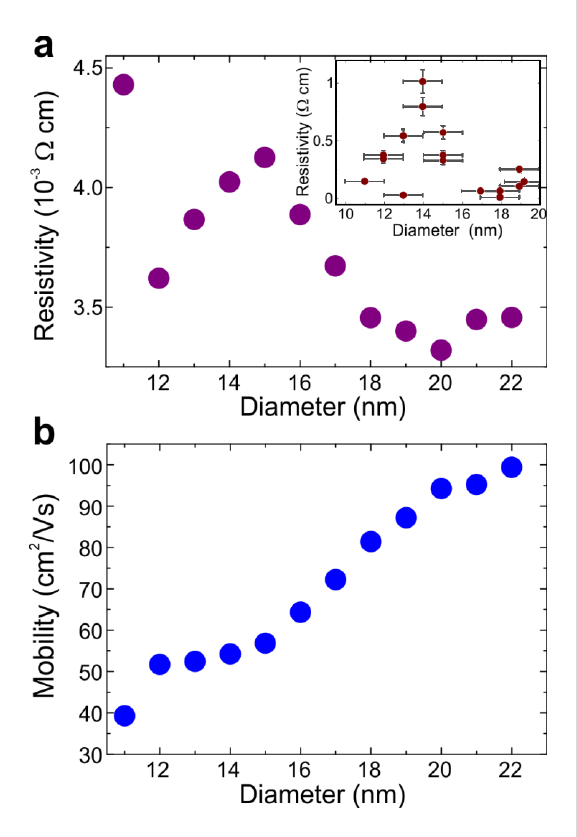
Figure 3: (a) Calculated nanowire resistivity from 22 to 11 nm diame- ter. Around 14 nm a peak-feature is found in agreement with the ex- perimental data. At 11 nm diameter, the sharp increase of the resis- tivity is due to the shift of the Fermi-energy below the third heavy-hole sub-band (Supporting Information File 1). (b) Nanowire mobility calcu- lated for the same diameter range as in (a). After an initial decrease, the mobility reveals a plateau-like region from about 12 to 15